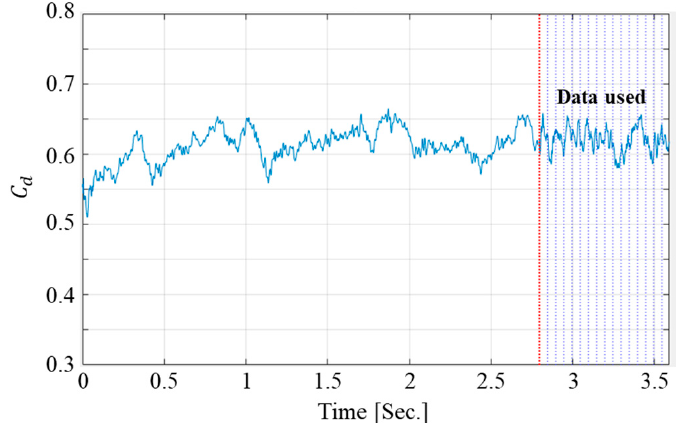
Figure 5. Calculated time history of aerodynamic drag of HSM.